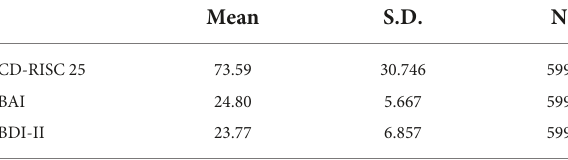
TABLE 1 Descriptive statistics for resilience, anxiety and depression.